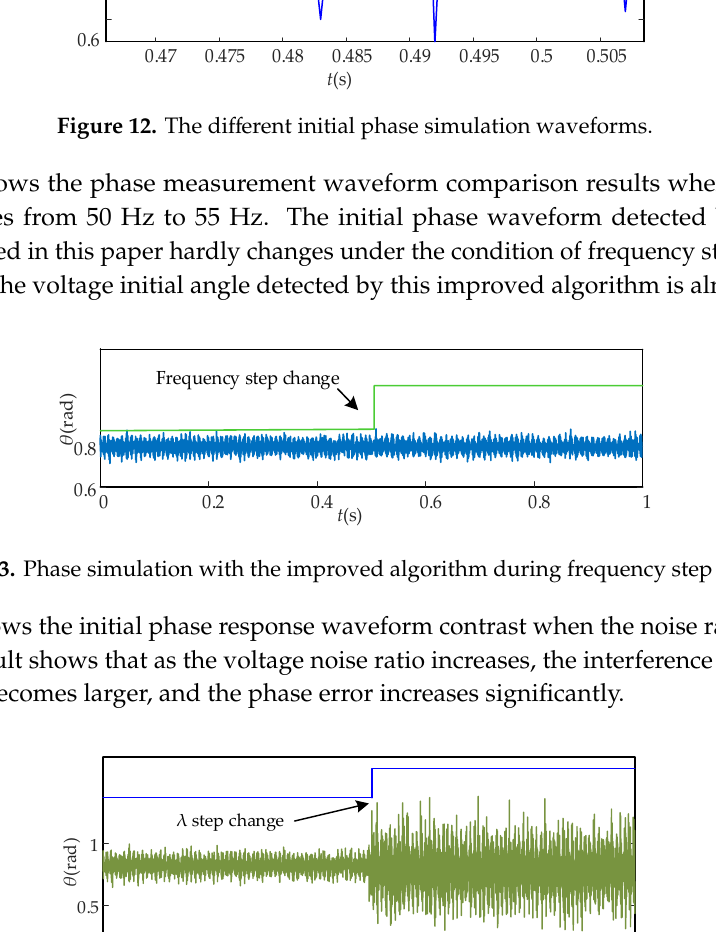
Figure 12. The different initial phase simulation waveforms.